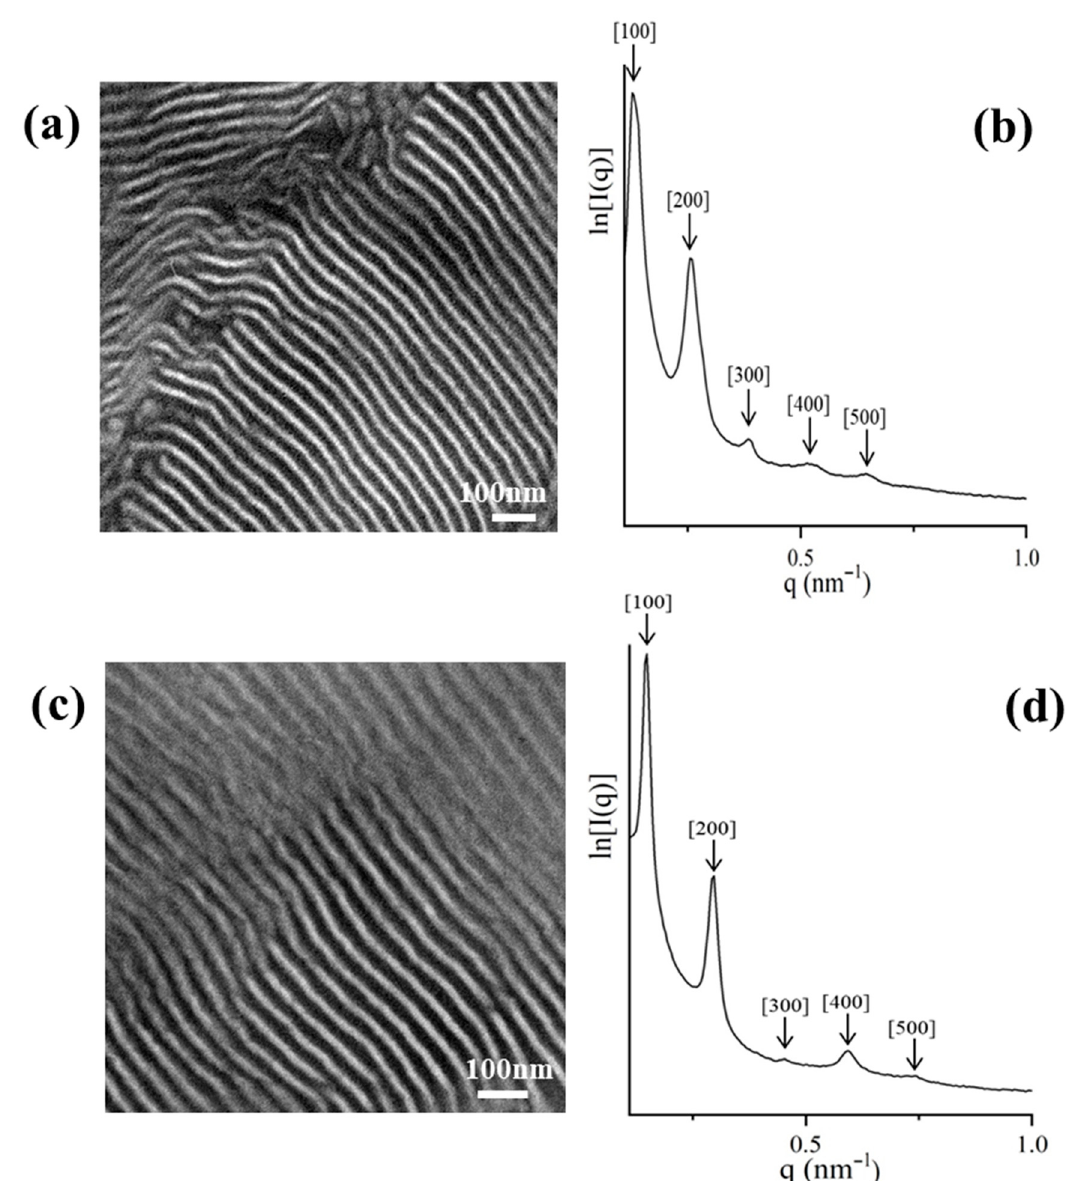
Figure 3. Bright-field transmission electron microscopy (TEM) images of the dendritic final terpolymer [(PS)(PI)(PB)] 3 -B 3 core and the corresponding dendron where in both cases 2-phase contrast is clearly indicated ( a , c ) after staining with vapors of OsO 4 aqueous solution and their relevant 1D small-angle X-ray scattering (SAXS) plots ( b , d ). In both cases, alternating lamellae domains are clearly observed in the TEM images and are verified by the observed peaks ratio at the 1D SAXS plots. In all TEM images, white areas correspond to PS and dark correspond to mixed PI and PB